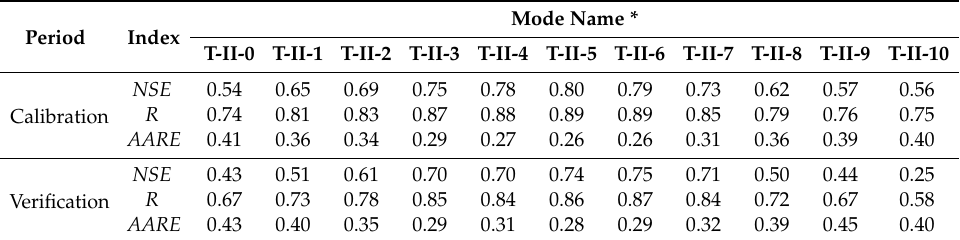
Figure 5. NSE values of the WA-ANN modeling results by two decomposition types under 10 decomposition levels. The result under the decomposition level 0 is obtained by using original series. Table 3. Modeling results of WA-ANN models when using the T-II decomposition type.